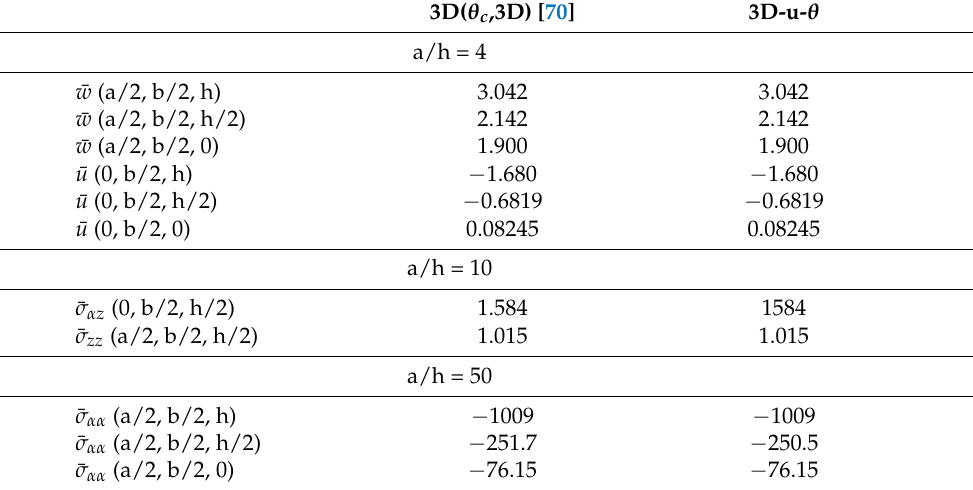
Table 1. First preliminary assessment, one-layered FGM ( p = 2) square plate with external sovra- temperature amplitudes Θ t = + 1 K and Θ b = 0 K for m = n = 1. Reference solution is the 3D uncoupled thermoelastic model by Brischetto and Torre [70] with the temperature profile calculated using the 3D Fourier heat conduction Equation (3D( θ c ,3D)). The new 3D coupled thermoelastic solution is 3D-u- θ .